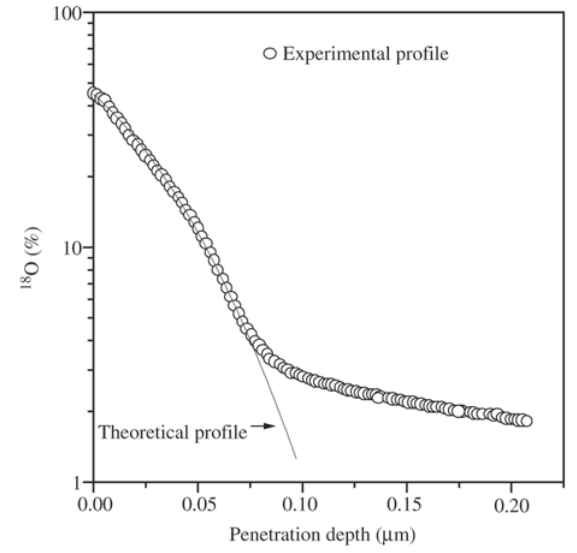
Figure 2. Concentration profile of 18 O in pure ZnO polycrystal after diffusion at 900